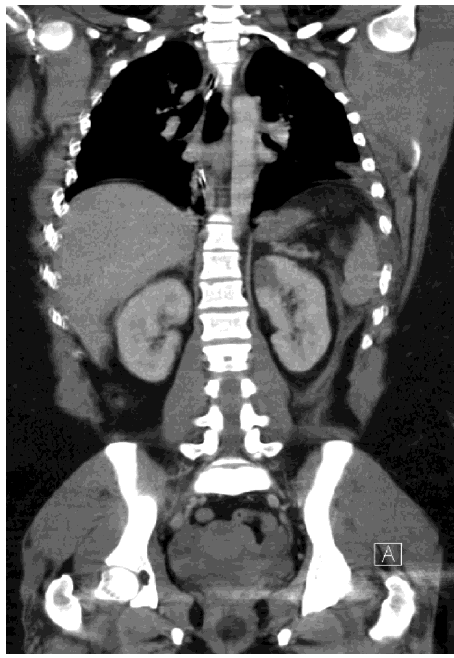
FIGURE 1. CT demonstrating inferior displacement of the Foley catheter balloon in the